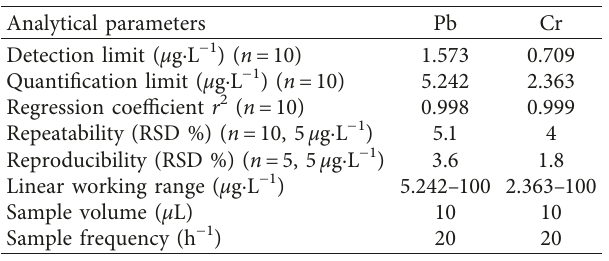
Figure 1: TXRF spectra of Pb, Cr, and Ga in a standard of calibration Table 1: Figures of merit for the simultaneous determination of Pb and Cr by the TXRF method.